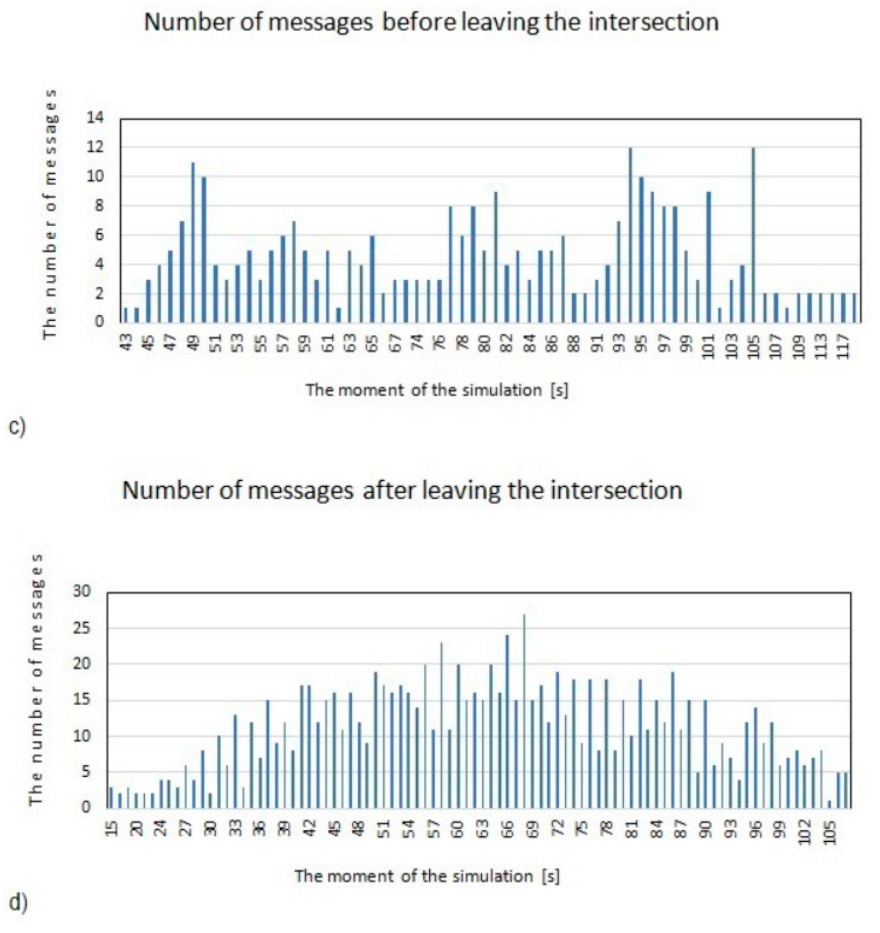
Figure 11. The network message flow at an intersection with one lane in one direction. The simulation contained 55 vehicles leaving the intersection after the change of the light from red to green.